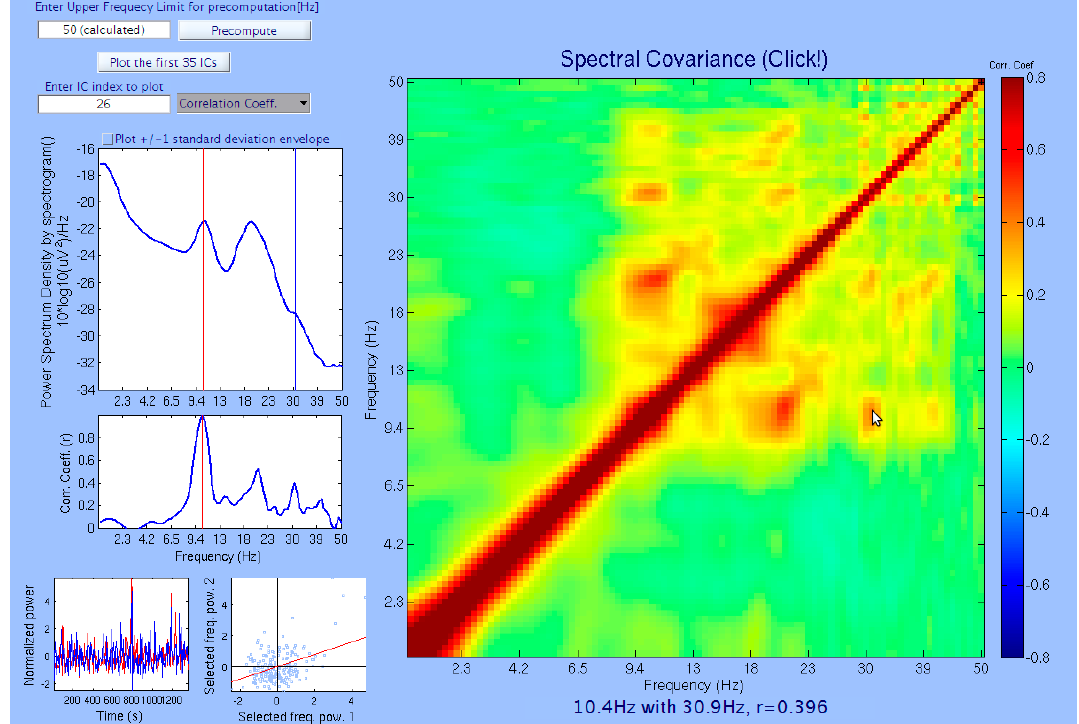
Figure 1. The main window of the toolbox that let users choose the cross-frequency points interactively by moving the mouse cursor over the right panel: currently, the cursor is pointing to the crossing point of 10.4 Hz and 30.9